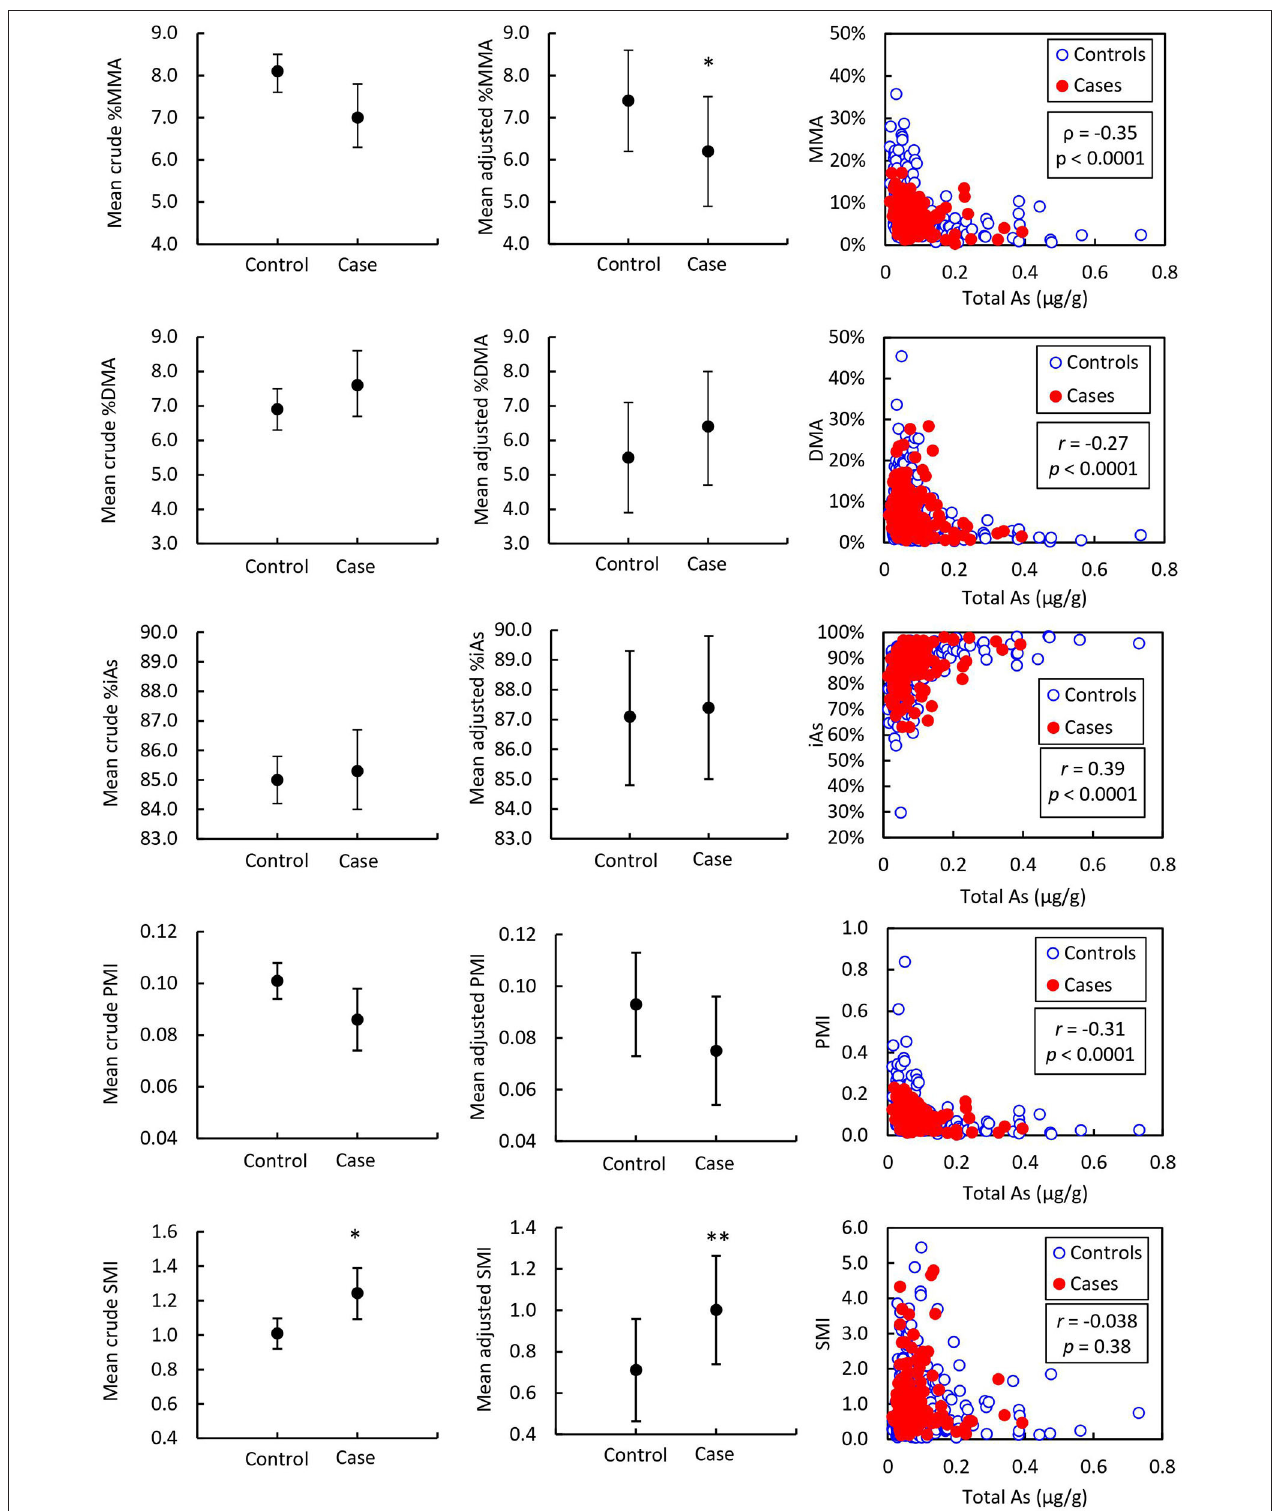
FIGURE 2 | Mean toenail arsenic species in prostate cancer cases ( n = 139) and controls ( n = 400) and correlation with total arsenic. Asterisks indicate the statistical significance of the mean difference between prostate cancer cases and healthy controls; * indicates p < 0.01. Error bars indicate 95% CI. r = Pearson correlation coefficient associated with the correlation between arsenic species and total arsenic. p = p -value associated with Pearson correlation coefficient.